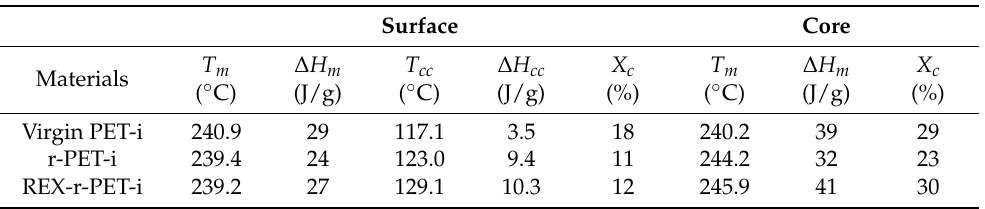
Figure 14. DSC scans of PET-injected samples: first heating runs from ( a ) the surface and from ( b ) the core of the injected specimens. Heating rates were 20 ◦ C/min in both cases. Table 5. Thermal properties of the PET-injected samples. All values were obtained from the DSC first heating scans shown in Figure